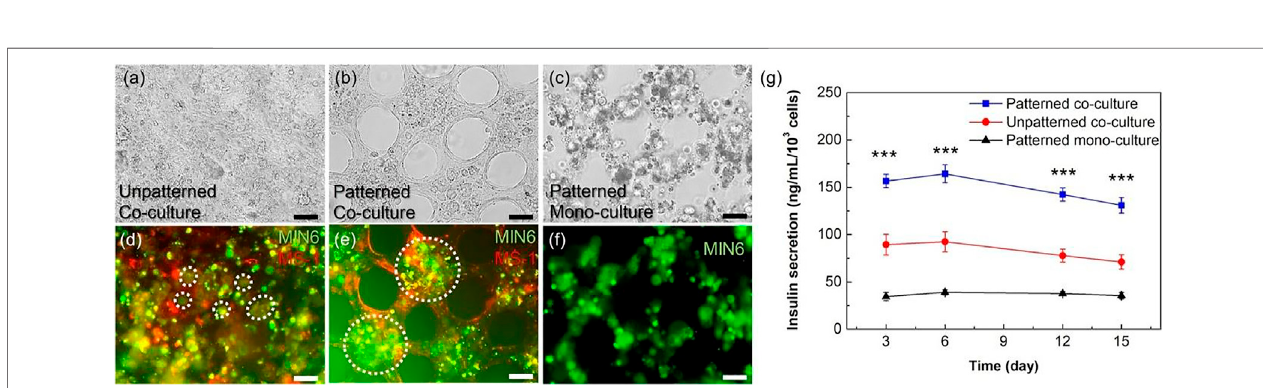
FIGURE 7 | Evaluation of the micro-patterns effect on cellular organization and function. Microscopic images of MIN6 and MS1 co-cultured sheets without (A, D) andwithpattern (B,E) .MicroscopicimagesofaMIN6mono-culturedsheetwithmicro-patterns (C,F) .In fl uorescenceimages,MIN6cellsarestainedingreen,andMS1 cells are stained in red. Cellular clusters are pointed by white dashed circles. (G) Insulin secretion level of MIN6 cells in mono- and co-cultured condition (patterned and non-patterned). Scale bars are 50 μ m, and p -value < 0.001 indicates signi fi cant differences (Seo et al., 2020).